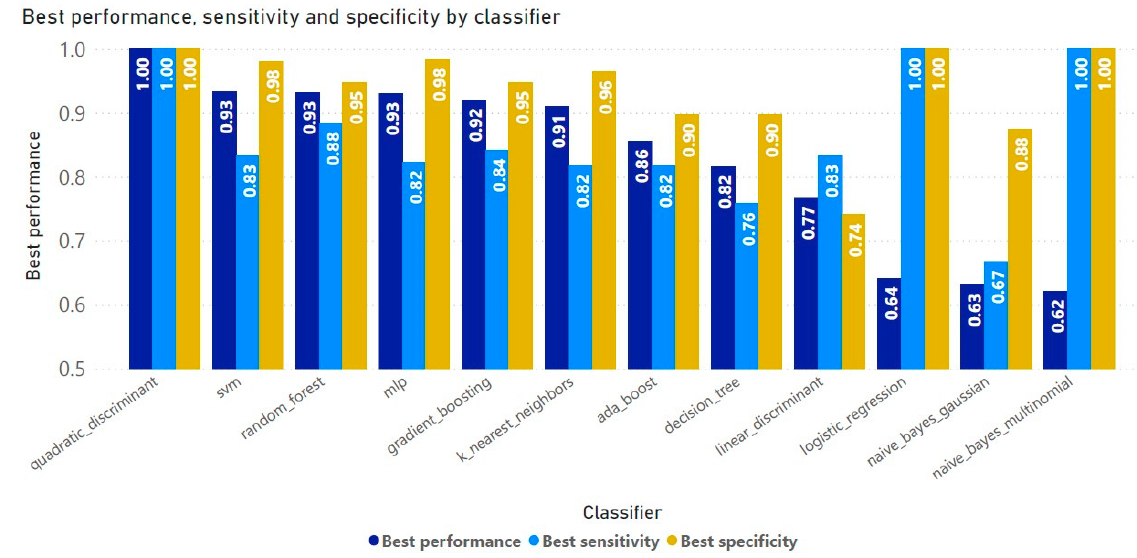
Figure 5. Depiction of the best achieved performance (dark blue), sensitivity (light blue), and specificity (yellow) computed from testing on 26 thresholds among each classification algorithm.